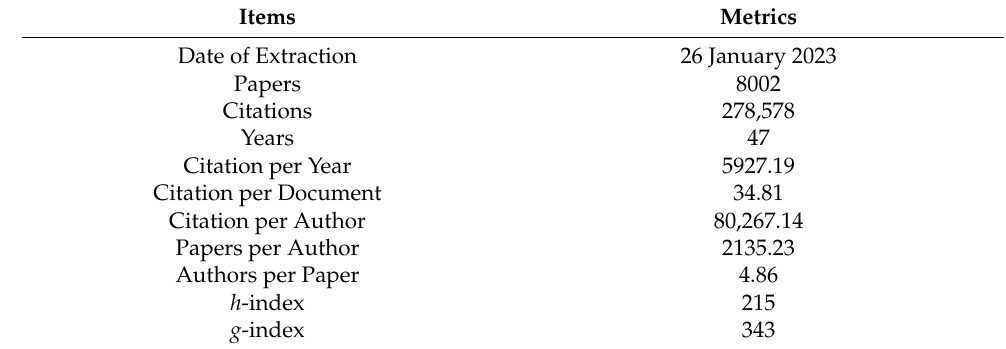
Table 9. Citation